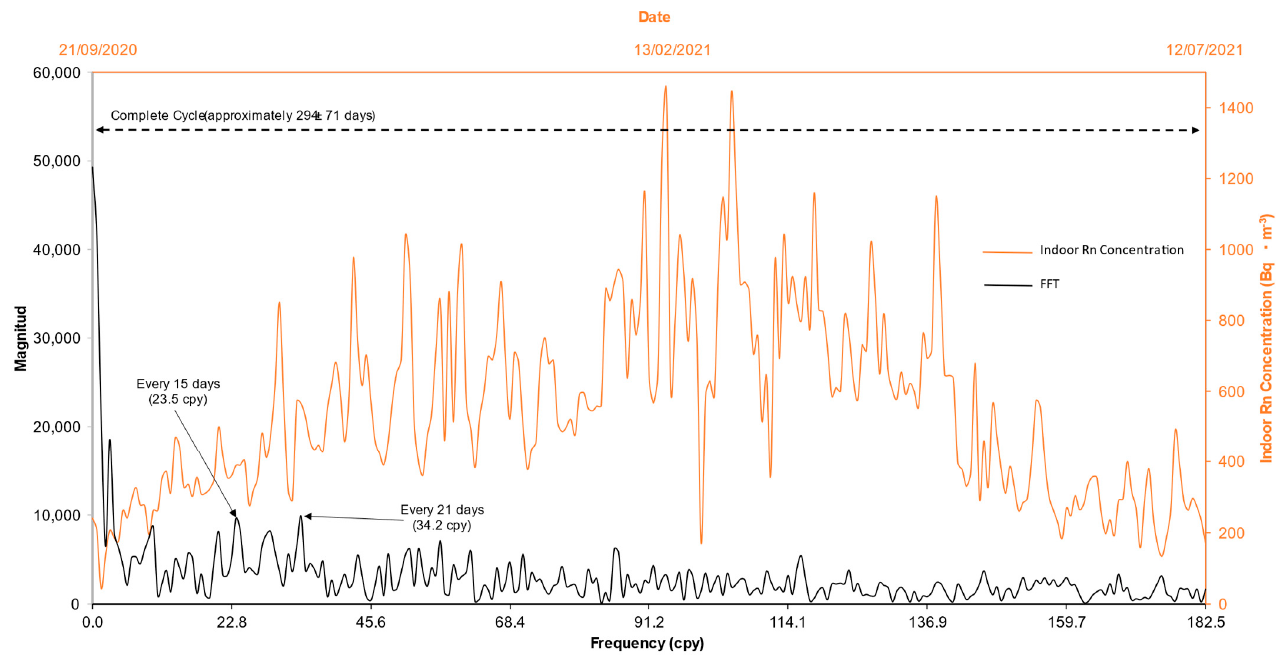
Figure 4. Schematic representation of the Fast Fourier Transform (FFT) application to the indoor Rn concentration measurements over the period under analysis (black line) with the superimposition of the indoor Rn concentration data (orange line).